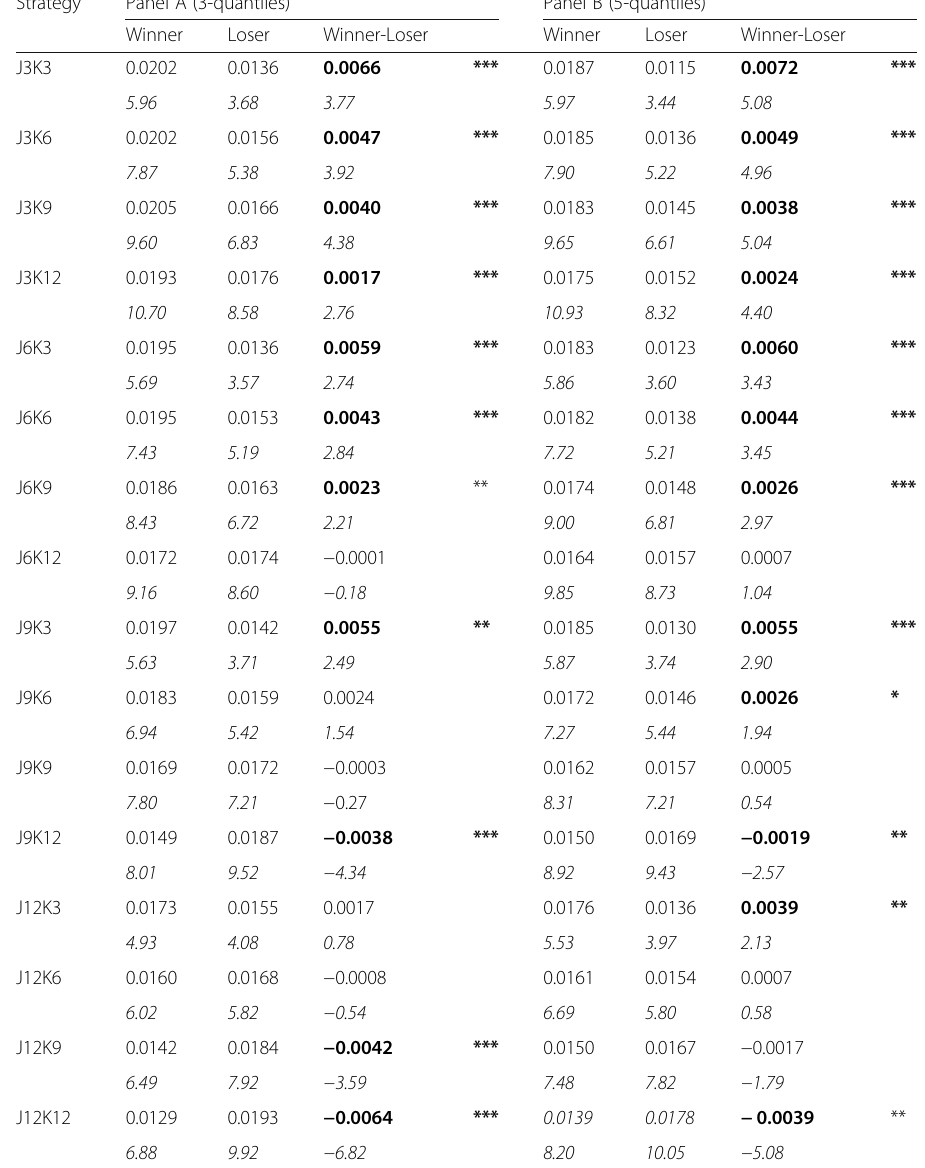
Table 1 Returns of Momentum Strategies (September 1995 to September 2014) Strategy Panel A